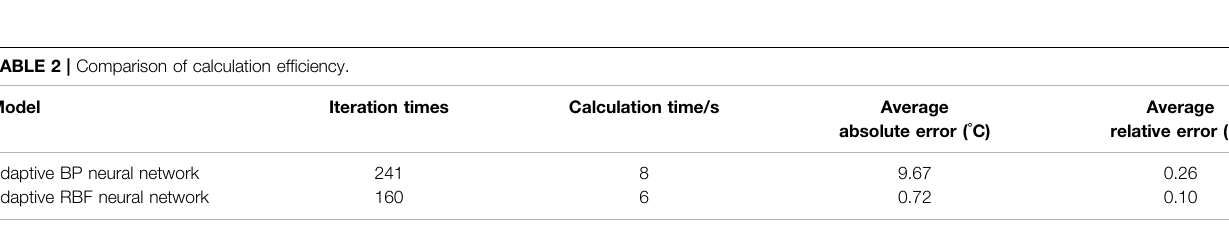
Prediction performance to the mass fl ow